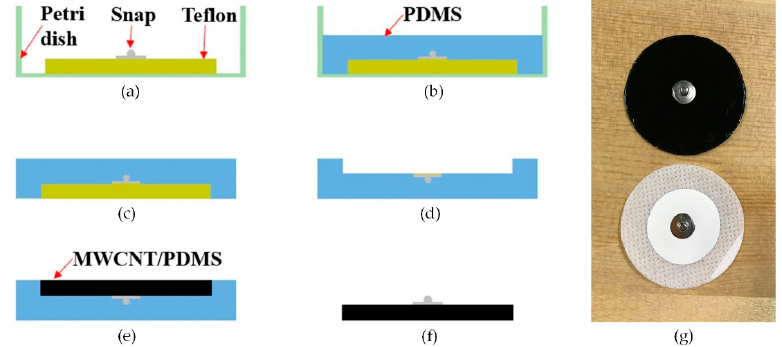
Figure 2. Fabrication process of the MWCNT/PDMS electrode. ( a ) A circular Teflon substrate and a metal snap were placed on petri dish. ( b ) The uniform mixture of the PDMS precursor and crosslinking agent was poured and cured in a vacuum oven. ( c ) The PDMS master mold was detached from the petri dish. ( d ) The Teflon was removed from the PDMS mold. ( e ) The prepared homogeneous mixture of MWCNTs and PDMS was poured into the PDMS mold and thermally cured in a vacuum oven. ( f ) A flexible dry MWCNT/PDMS electrode was detached from the PDMS mold. ( g ) The fabricated MWCNT/PDMS electrode (top) and the commercial Ag/AgCl electrode